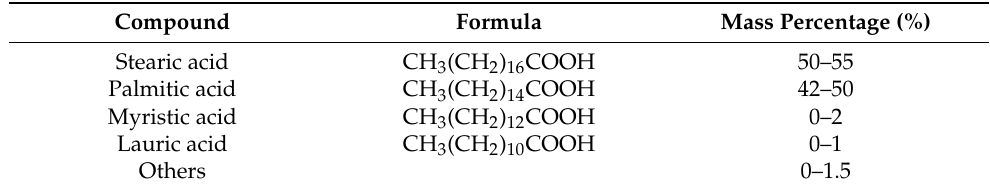
Table 1. Composition of the industrial grade fatty acid